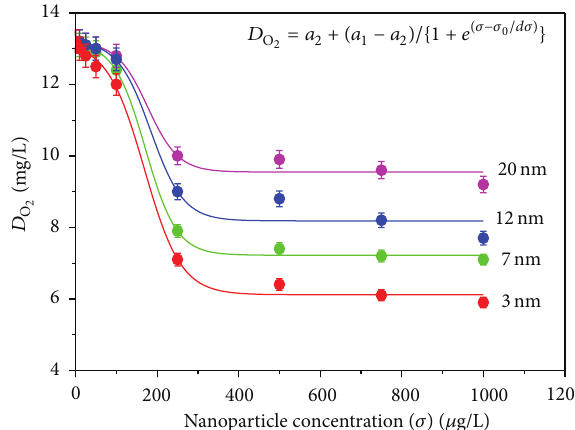
Figure 3: Variation of pH value of water due to exposure of ) in water due 2 ZnS nanoparticles of different sizes with increasing nanoparticle concentration ( 𝜎 ) for a fixed exposure time ( 𝑡 = 6